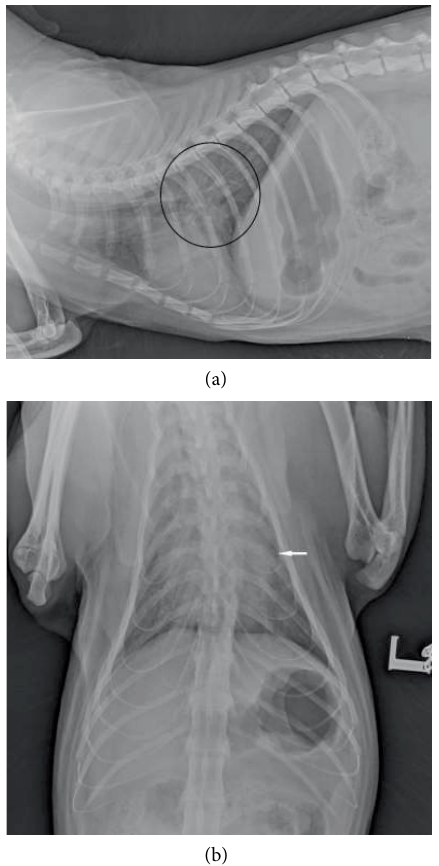
Figure 2: (a) Follow-up thoracic radiographs of the patient. Right lateral view: Caudal lung field showed noticeable resolution of described patterns (black circle). (b) Follow-up thoracic radiographs of the patient. Dorsoventral view. Decrease in radiopacity of the left caudal lung lobe (white